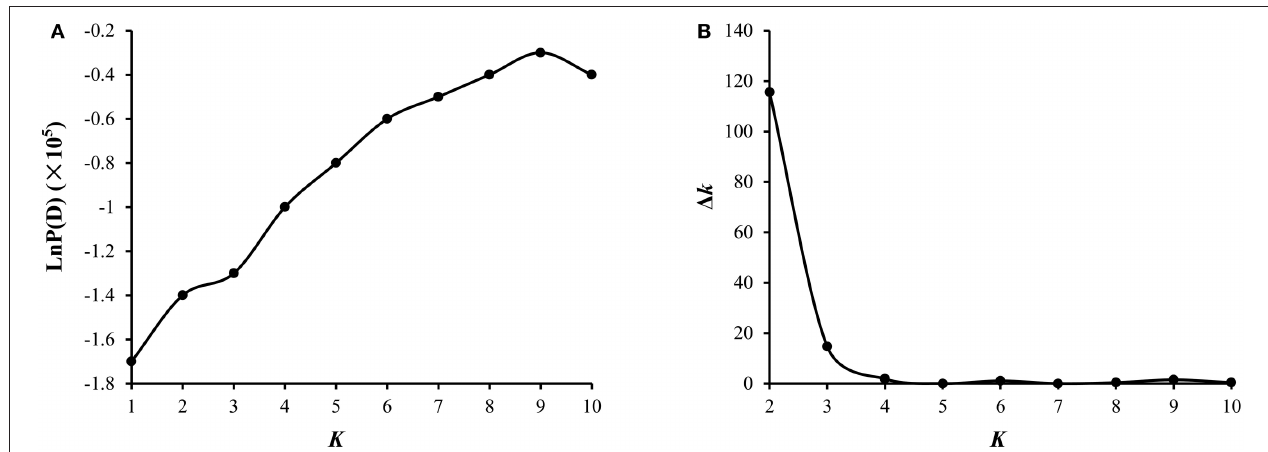
FIGURE 1 | Analysis of the population structure of 81 B. carinata accessions. (A) Estimated LnP(D) of possible clusters ( K ) from 1 to 10. LnP(D), the log likelihood of the data in the STRUCTURE output. (B) 1 K based on the rate of change of LnP(D) between successive K as described by Evanno et al. (2005).